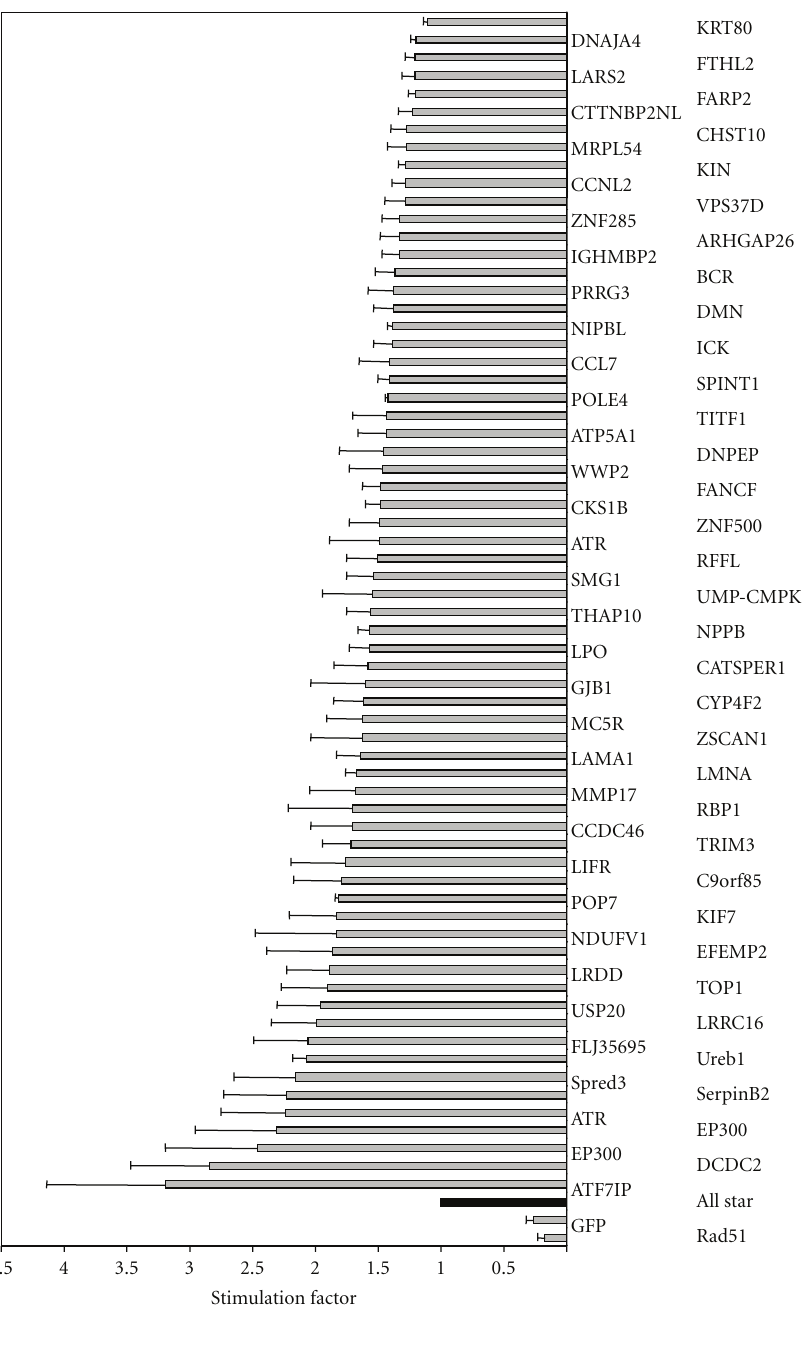
Figure 4: Hits selected after secondary screening. Cells were cotransfected with 200ng of RMGFP+I-SceI and a panel of di ff erent siRNAs, as indicated, at a final concentration of 33nM. GFP fluorescence was detected by flow cytometry 96h after transfection. The results are expressed as the stimulation factor, corresponding to the ratio of the percentage of GFP-positive cells in the presence of the siRNA hit to that following transfection with the control siRNA (AS). Four independent experiments were performed and Student’s t -tests were used to assess the significance of di ff erences in stimulation factor ( P value < .05). Two siRNA controls were used to validate siRNA transfection: RAD51 and GFP siRNAs. The RAD51 and GFP siRNAs decreased the percentage of GFP-positive cells by factors of 6 and 4 with respect to the AS control siRNA, demonstrating that the siRNAs were